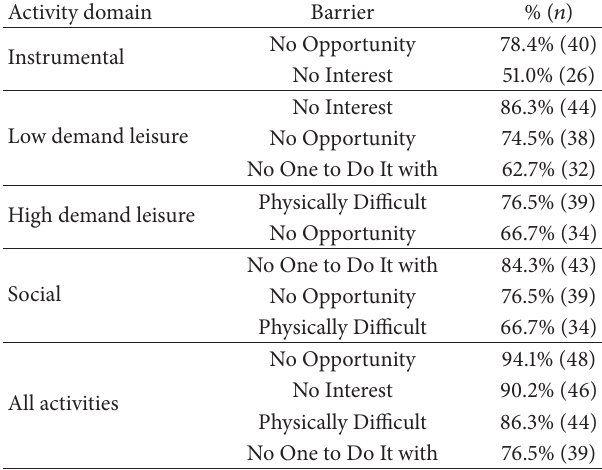
Table 2: Top ten activities participants have given up or are doing less.